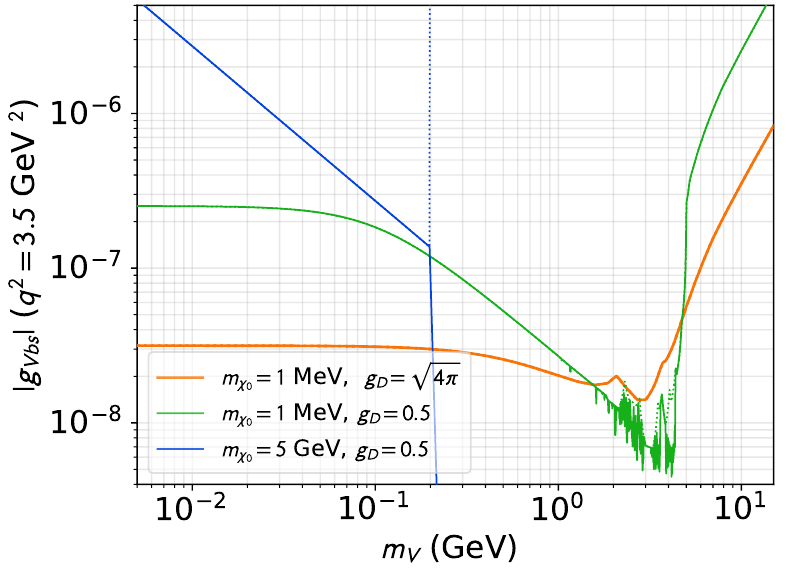
Figure 3 . Upper bound on j g V bs (3 : 5 GeV 2 ) j as a function of m V for various choices of the input parameters. We set Q (cid:8) = 1. The speci(cid:12)c impact of the di(cid:11)erent constraints is described in the main